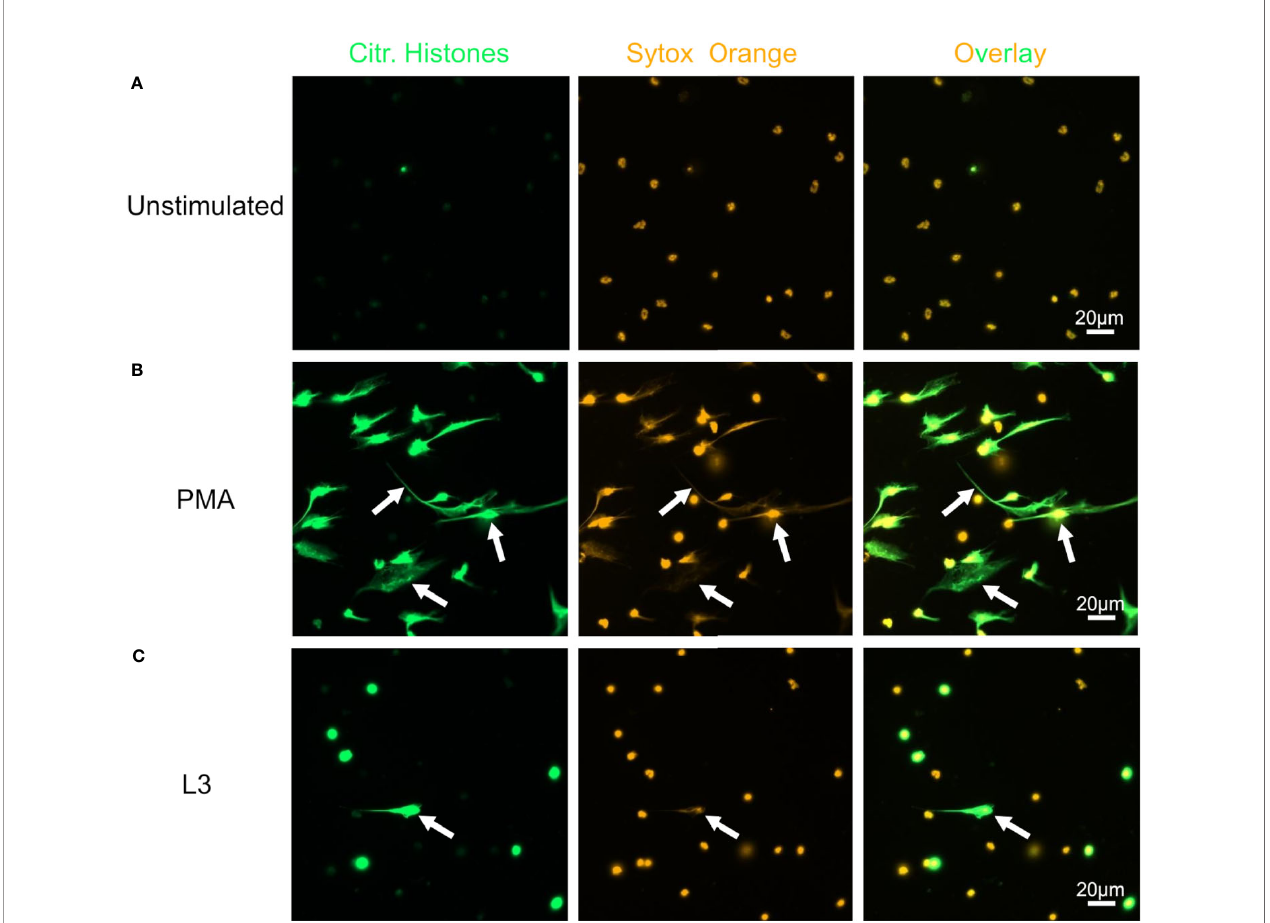
FIGURE 4 | S. ratti L3 induce NETosis. Representative fl uorescence microscopy pictures of neutrophils left unstimulated (A) , stimulated with PMA (B) or S. ratti L3 larvae (C) . Cells were stained for citrullinated histones (green, left pannel) and for DNA with Sytox orange (orange, middle pannel), right pannel shows the overlay. Shown are the results from one out of two independent experiment with n = 2. S. ratti larval opsonization by immune plasma in vitro was determined by fl uorescence microscopy and is shown in Supplementary Figure S5